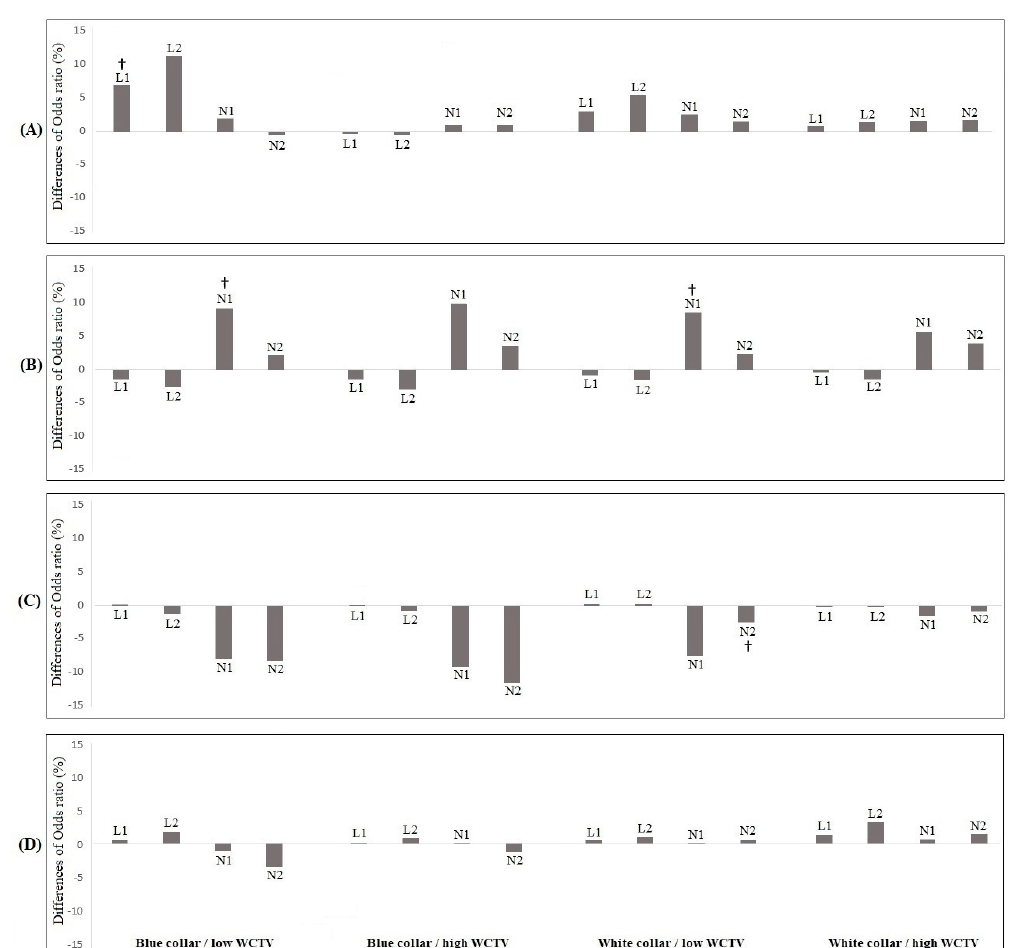
Figure 2. Differences in the odds ratios of long working hours and night work on low subjective well-being from a model adjusted for ( A ) working-time mismatch, ( B ) working-time variability, ( C ) shift work, and ( D ) working-time autonomy to the model not adjusted. L1 indicates 52–60 h per week, L2 indicates >60 h per week, N1 indicates night work for 1–10 days per month, and N2 indicates night work for >10 days per month. A change was considered “substantial” when the ORs changed by >10% or the statistical significance changed (†: A change in statistical significance, WCTV: work creativity and task variety). Odds ratio adjusted for all other confounders (sex, age, education level, numbers of employee, subjective health condition, and monthly